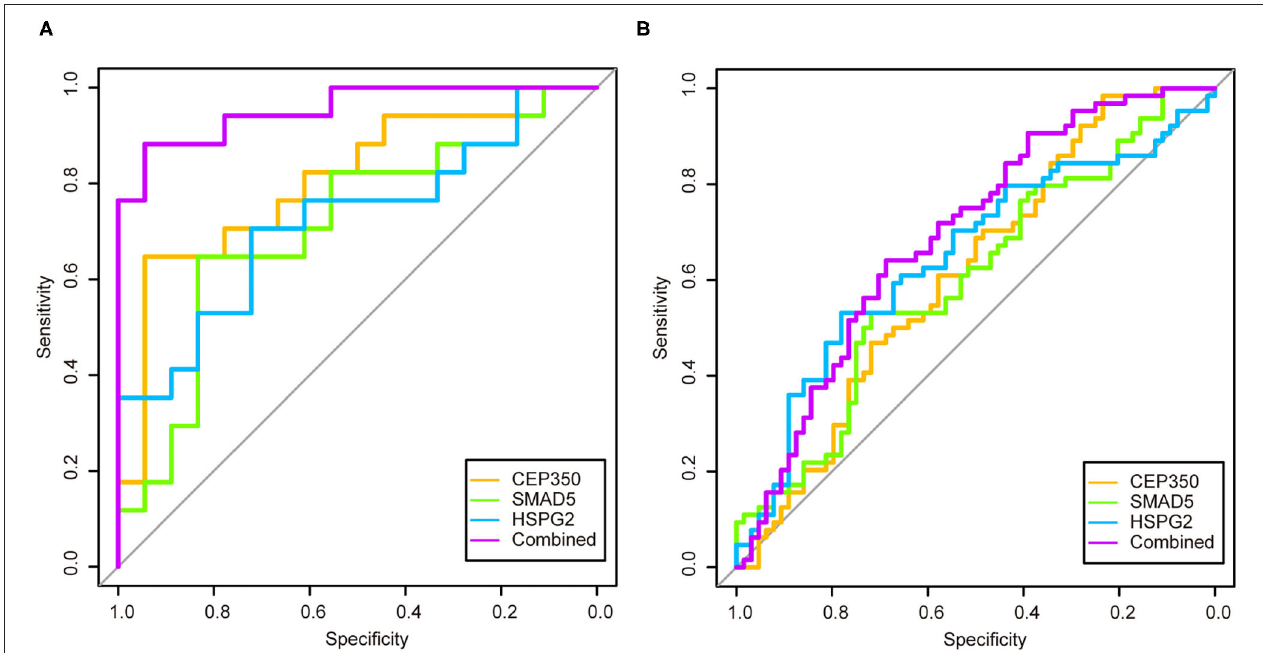
FIGURE 4 | The receiver operator characteristic curves and area under the curve of the candidate genes in two datasets. (A) Receiver operator characteristic curves and area under the curve of the candidate genes of GSE53987; (B) Receiver operator characteristic curves and area under the curve of the candidate genes of